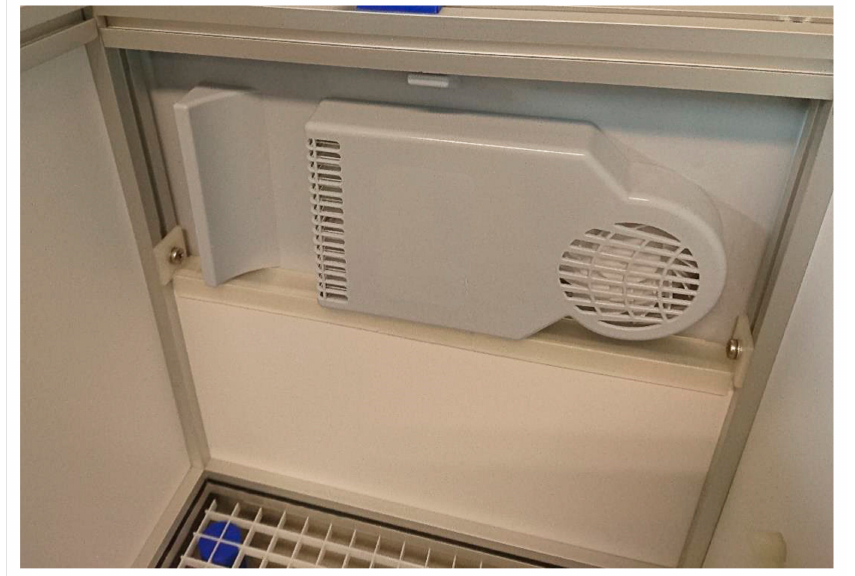
Figure 7. Peltier module-based cooling system installed in the